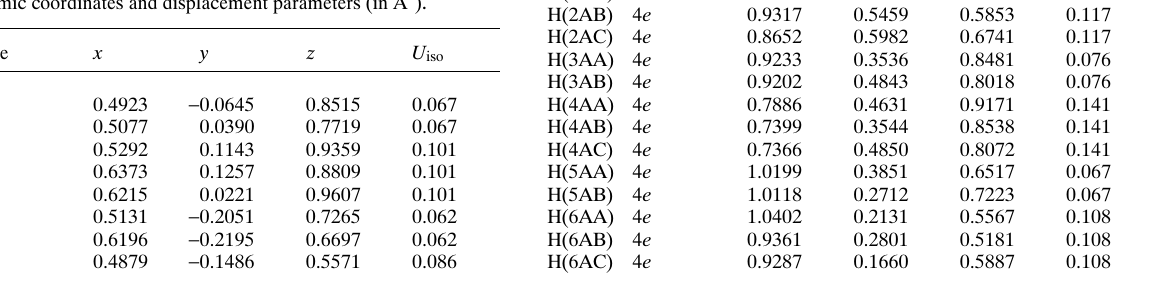
Table 2. Atomic coordinates and displacement parameters (in Å 2 ) .